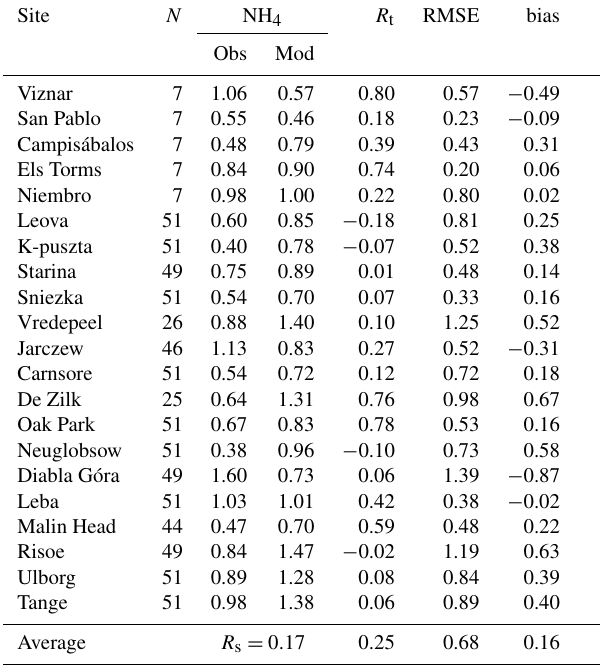
Table 8. Scores for the comparisons between observations (EMEP) and model (CHIMERE) for the NH 4 surface concentrations (in µgm − 3 ). Results are presented with N the number of daily mean available measurements for the period from 10 June to 30 July 2013, the observed and modeled surface concentrations (“obs” and “mod”), the temporal correlation ( R t ), the root mean square error (RMSE) and the absolute bias (model minus observations). The last line “average” represents the spatial correlation R s between the mean observed and modeled values, and the mean averaged values of temporal correlation, RMSE and bias. Stations are sorted in in- creasing latitude, from south to north.